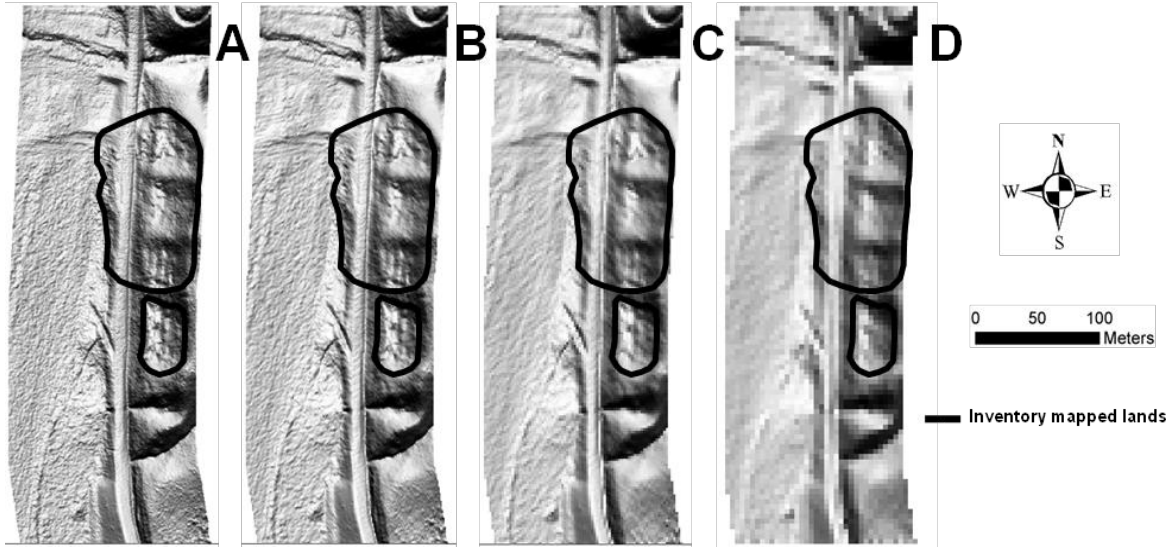
Figure 2. DEM maps with 50 (A), 100 (B), 200 (C), and 400 (D) cm spatial resolution. The areas outlined in black are the inventory mapped landslides.